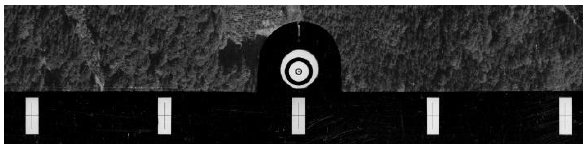
Figure 3. Additional FM along the AAP circumference 2.1.3